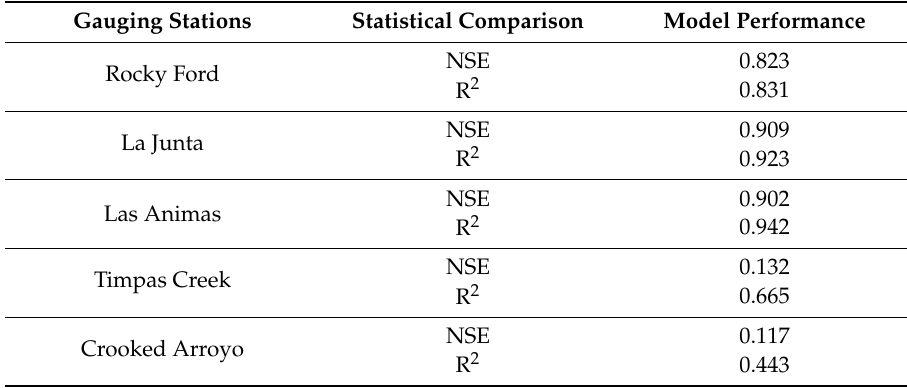
Figure 7. Monthly simulated and observed streamflow comparison for a SWAT-MODFLOW model at Rocky Ford, La Junta, and Las Animas (outlet) (see Figure 2B), with corresponding coe ffi cient of determination. Table 2. Nash–Sutcli ff e e ffi ciency (NSE) and the coe ffi cient of determination (R 2 ) of simulated streamflow at the five gauging stations within the study